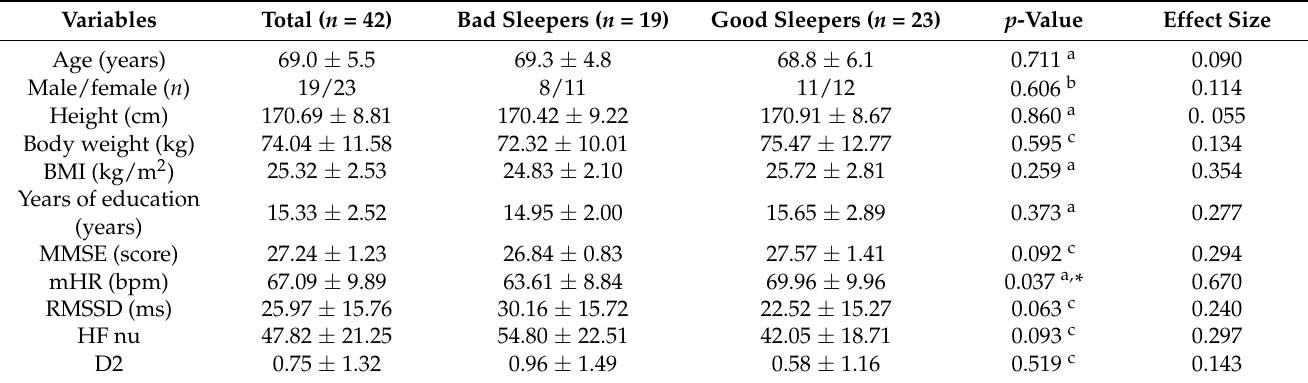
Table 1. Characteristics of participants and HRV data (Mean ± SD).